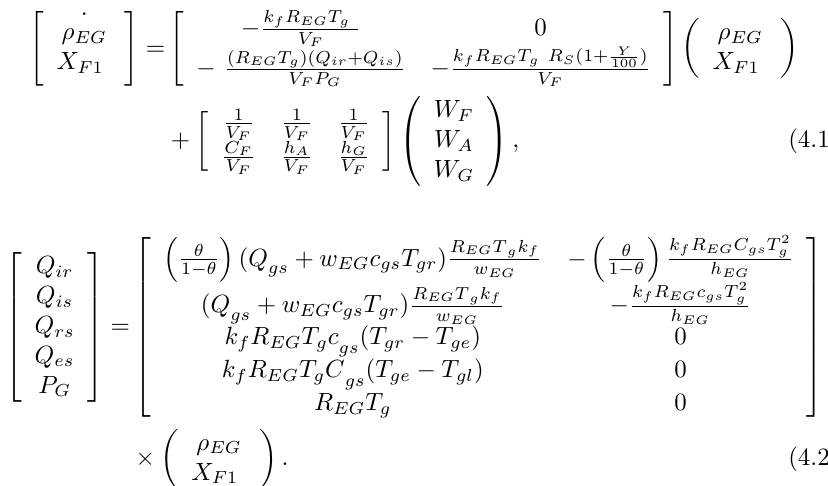
space equations [9] for the